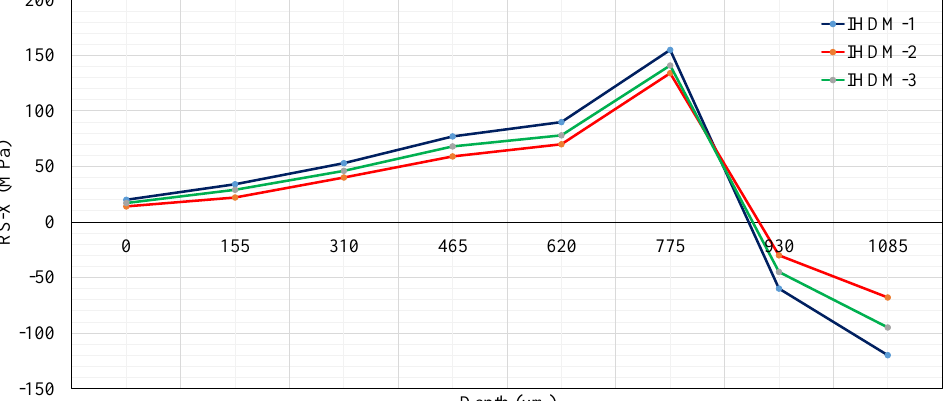
Figure 12. CFRP residual stresses in the